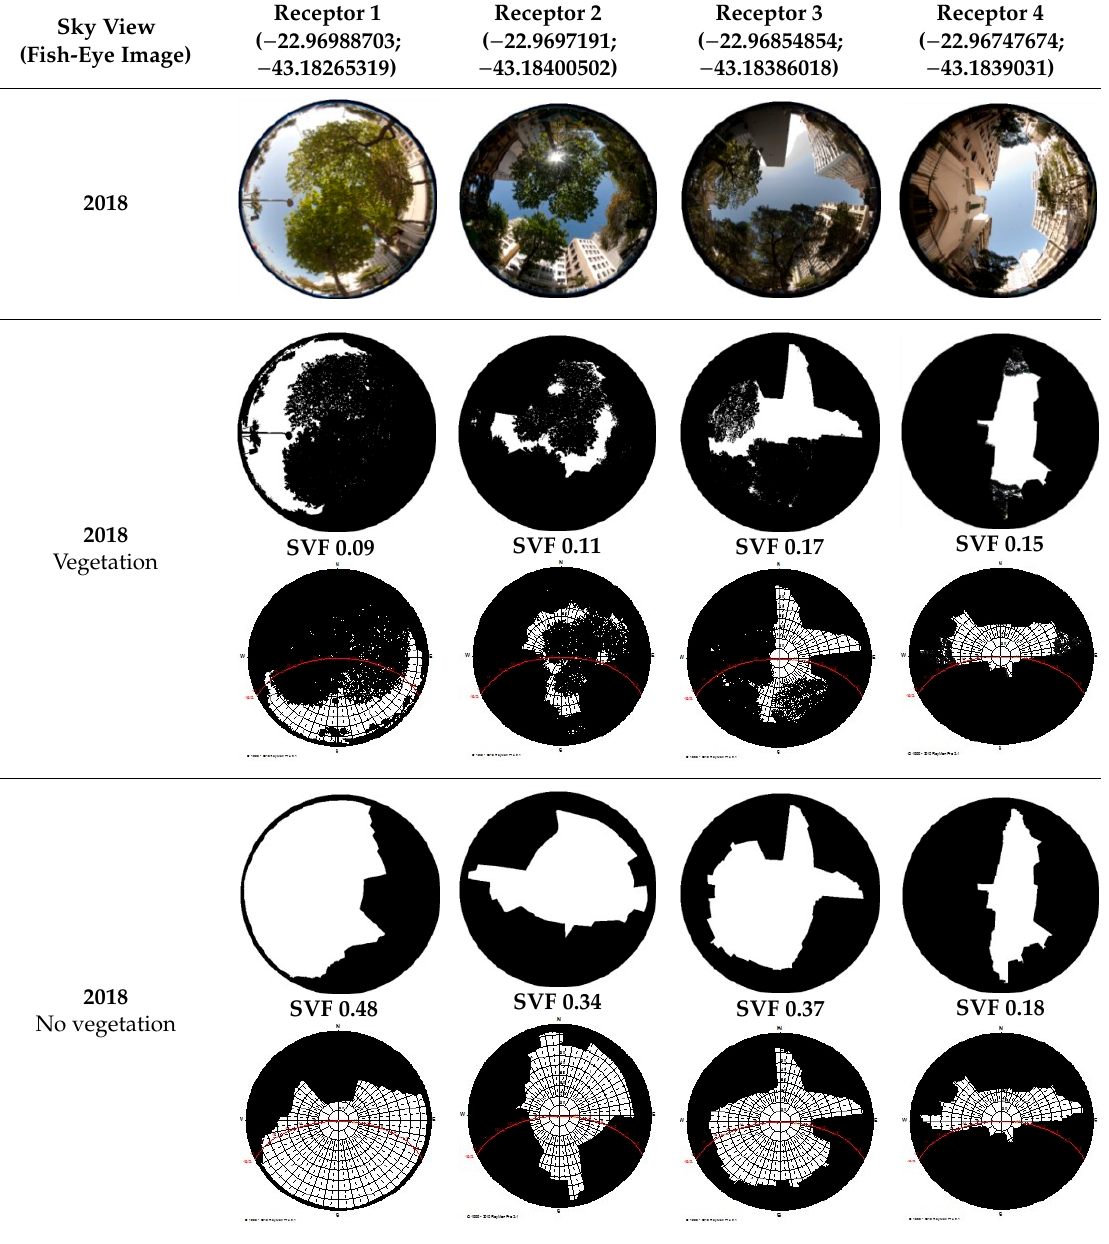
Table 1. Images of the sky taken with a fisheye lens, black and white masks, sky view factor (SVF), and the solar path.